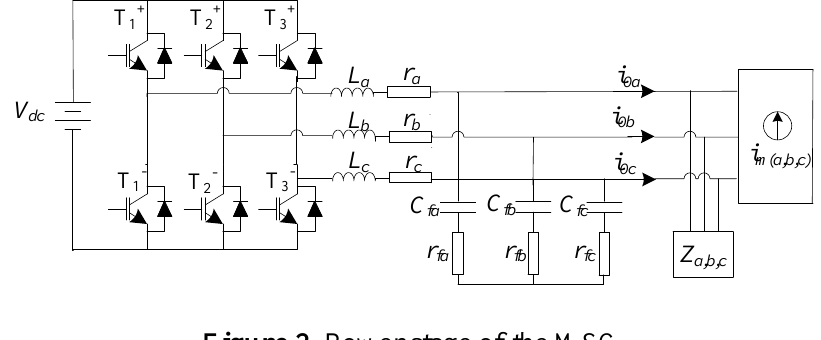
Figure 2. Power stage of the